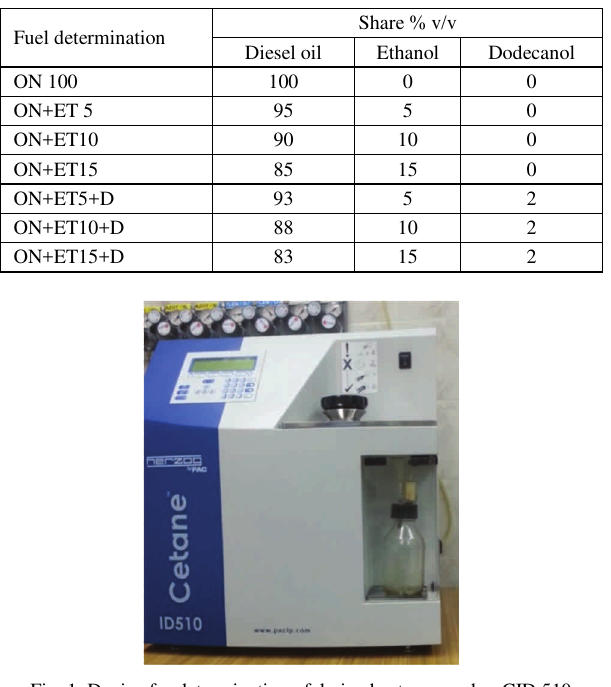
Fig. 1. Device for determination of derived cetane number CID 510